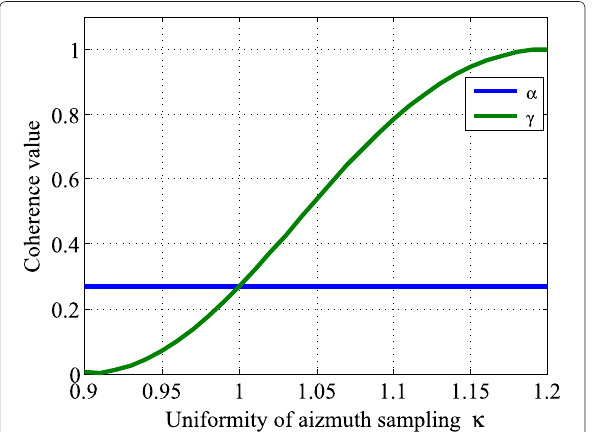
Fig. 5 Calculation result of coherence α and γ versus the uniformity of azimuth sampling